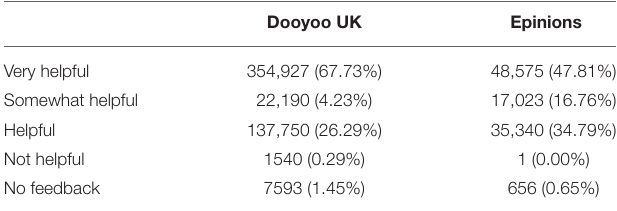
TABLE 4 | Ratios of community feedback values for the reviews of each